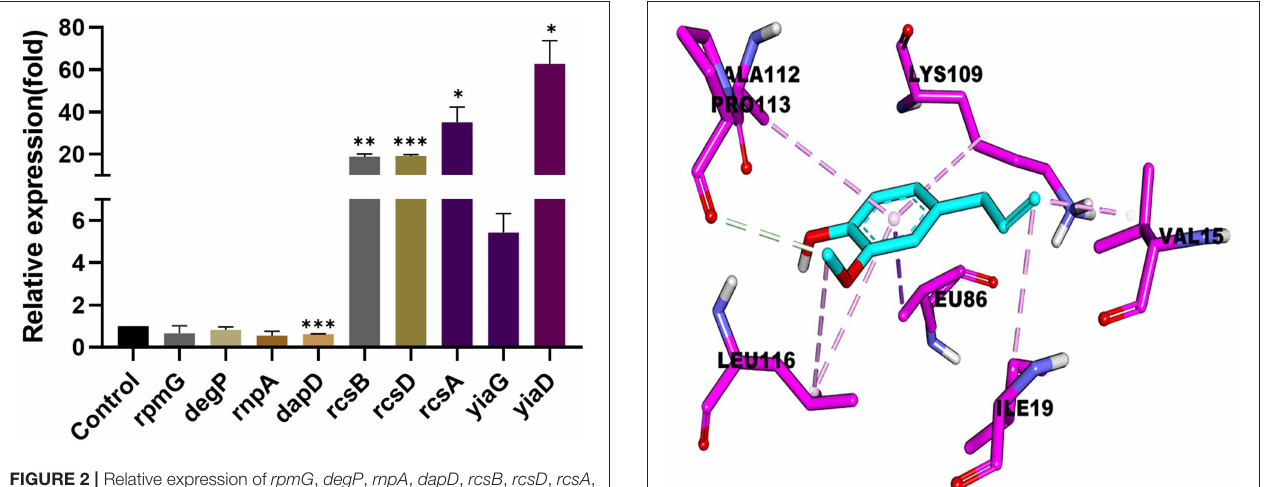
FIGURE 2 | Relative expression of rpmG , degP , rnpA , dapD , rcsB , rcsD , rcsA , yiaG, and yiaD . The *, **, and *** denotes P < 0.05, P < 0.01, and P < 0.001 respectively.